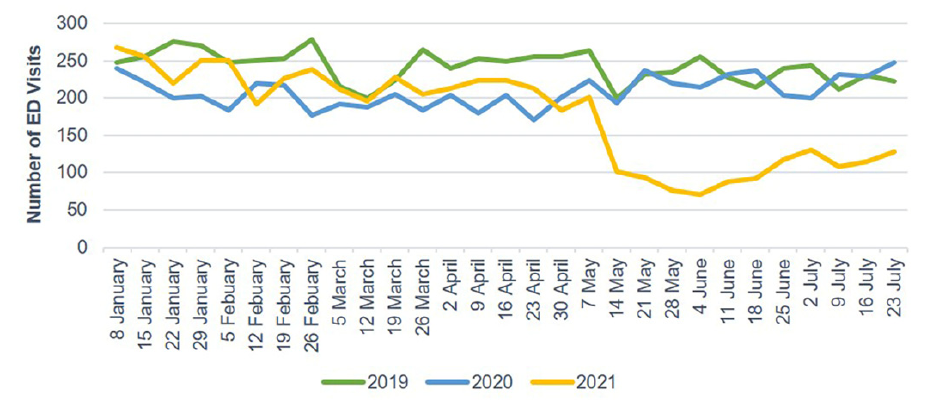
Figure 4. Weekly ED visits due to mild head injury from January to July 2019, 2020, and 2021. ED, emergency department.